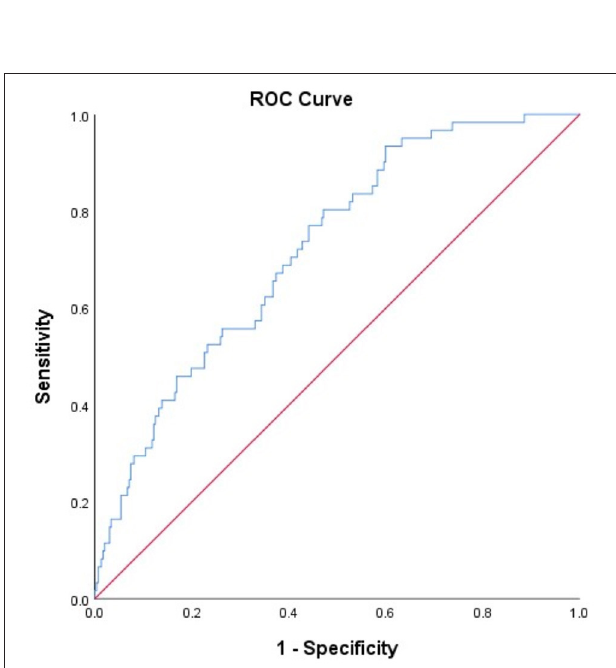
FIGURE 2 | Modified Rankin Scale (mRS) scores at 90 d in patients with and without symptomatic intracranial hemorrhage (sICH). There was a statistically significant difference between two groups in the overall distribution of mRS scores in an analysis with univariable ordinal regression (common odds ratio, 0.23; 95% confidence interval, 0.957–2.020), indicating a shift toward poor functional outcome, with non-sICH patients as reference group.